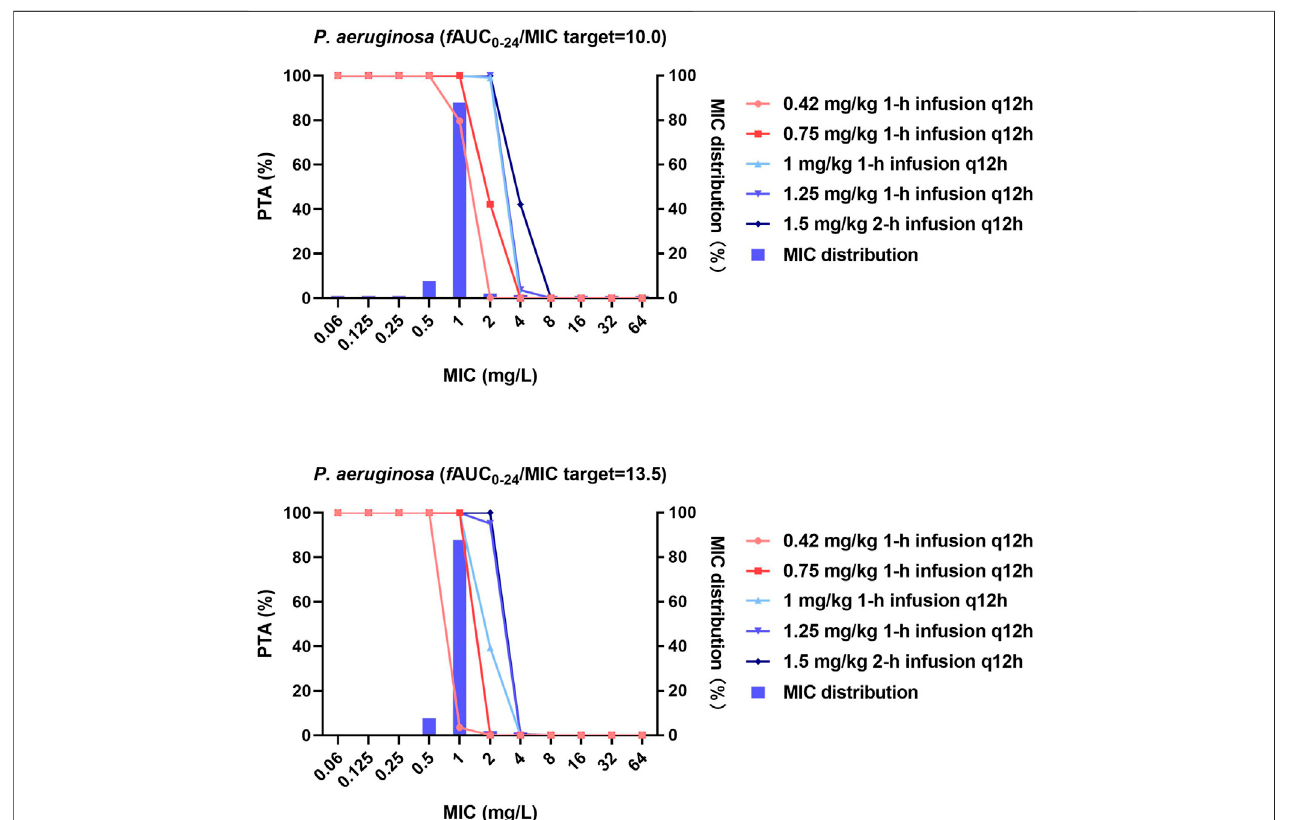
FIGURE1| MICdistributionandPTAofdifferentpolymyxinBdosingregimensagainst P.aeruginosa .MICsof > 32 mg/Larerepresentedby64 mg/LandPTAwas determined using the AUC 0 – 24h at steady state. The f AUC 0 – 24h /MIC targets of 10 and 13.5 represent 1-log 10 CFU and 2-log 10 CFU reductions, respectively.